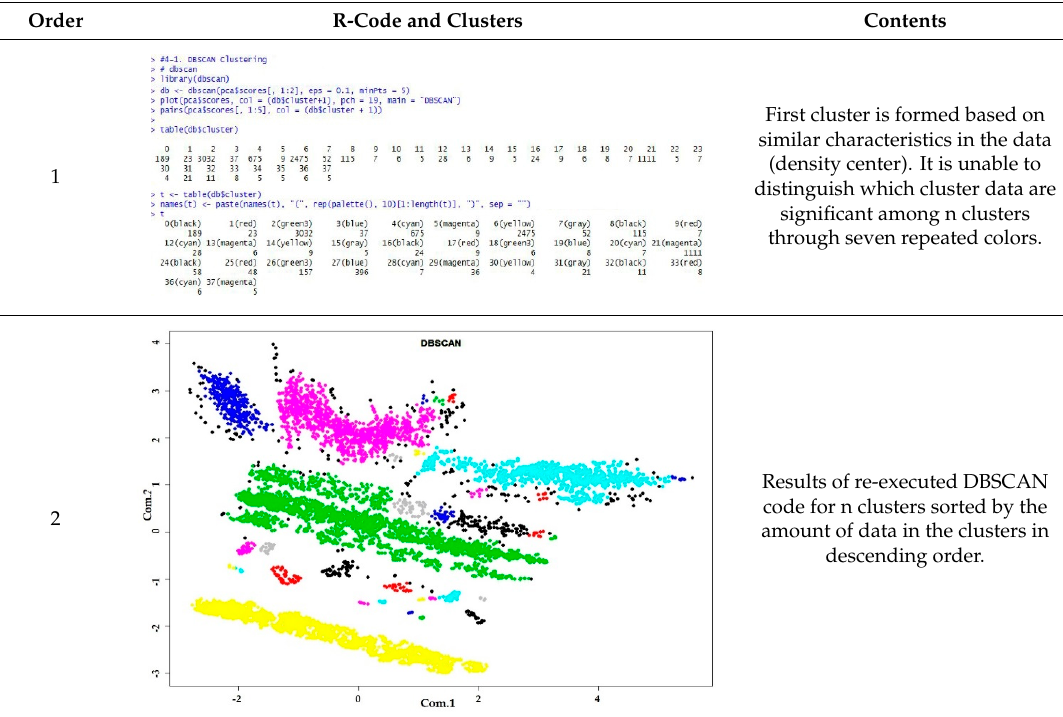
Figure 2. Schematic representation of the research process.